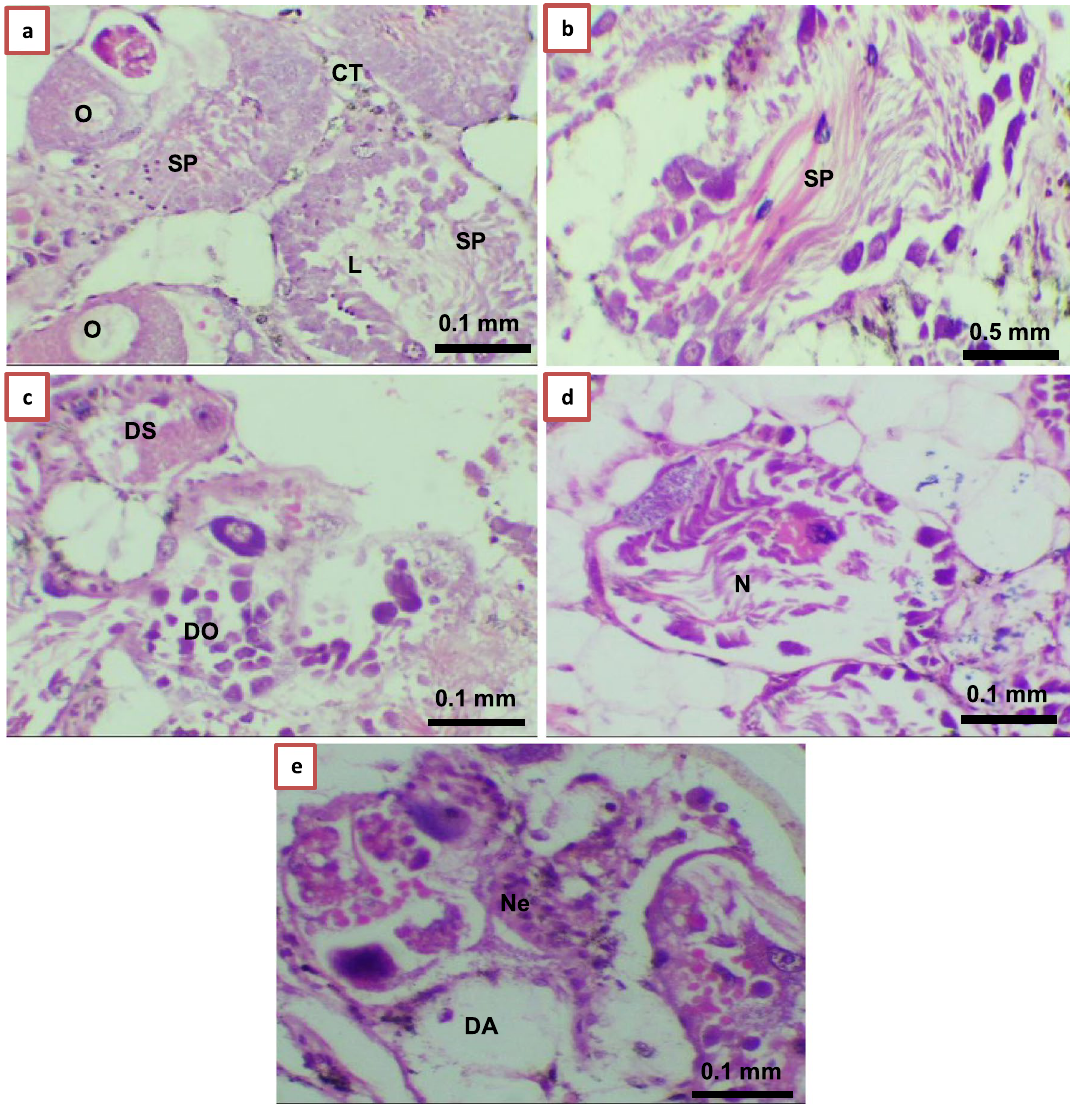
Fig. 6 Light micrographs showing the effect of RIPEX 48% EC on the ovotestis of Biomphalaria alexandrina . a : Control showing lumen (L), spermatozoa (SP), ova (O), and connective tissue (CT). b , c Snails exposed to 8 µL/L, showing degenerated spermatozoa (DS) and degenerated ova (DO). d , e Snails exposed to 16 µL/L show necrosis (Ne) and degenerated acinus